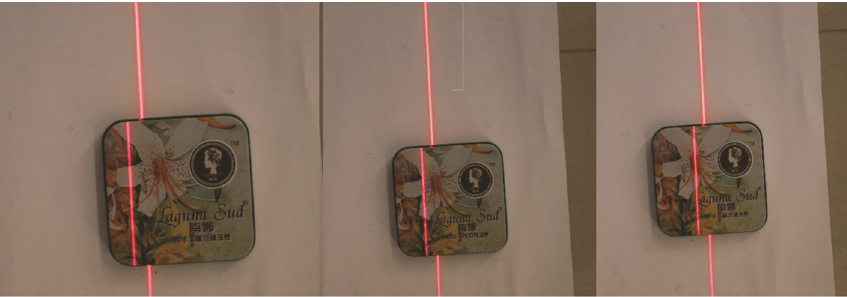
Figure 13: Rectangular physical photograph.